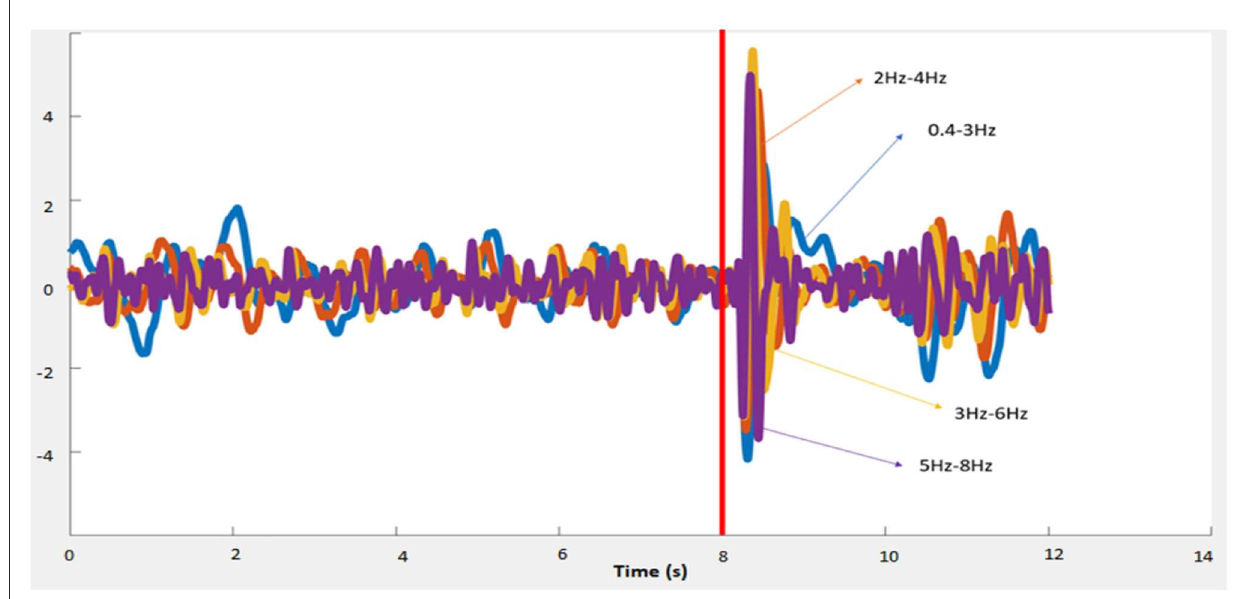
FIGURE3 Average for all channels with different frequencies, in relation to the red laser event for subject SE.1.